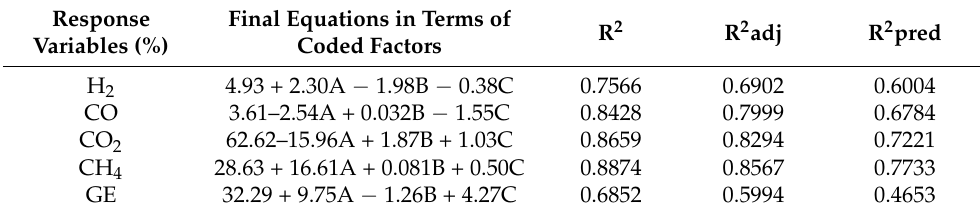
Table 6. Model equations for response